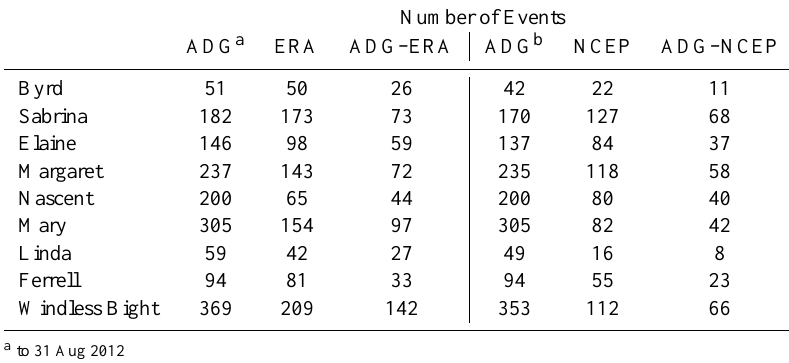
Table 3. Percentages of ADG events captured by reanalysis datasets, the amount of precipitation captured by those events (as a percentage of the total reanalysis precipitation), and percentage of reanalysis events that are not seen in ADG data (“false” events) for each reanalysis dataset.